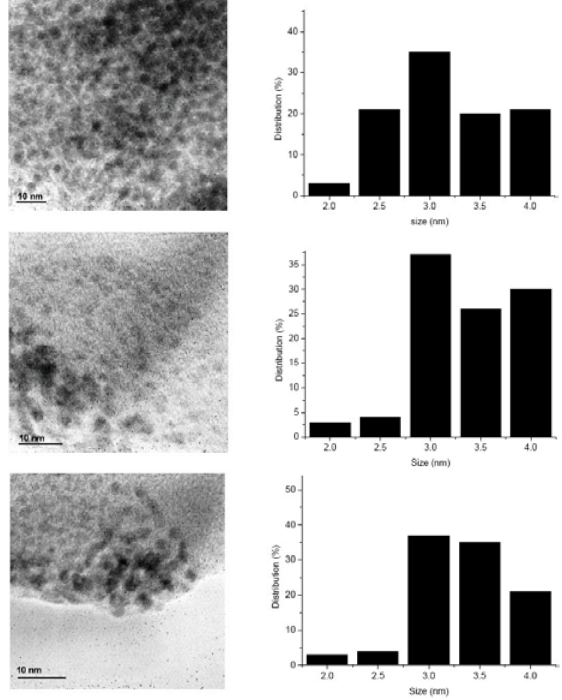
Figure 2. TEM image of palladium nanoparticles separated after Suzuki reaction. (Above: Specimen prepared from Entry 1 of Table 1; Middle: Entry 2; Below: Entry 4).